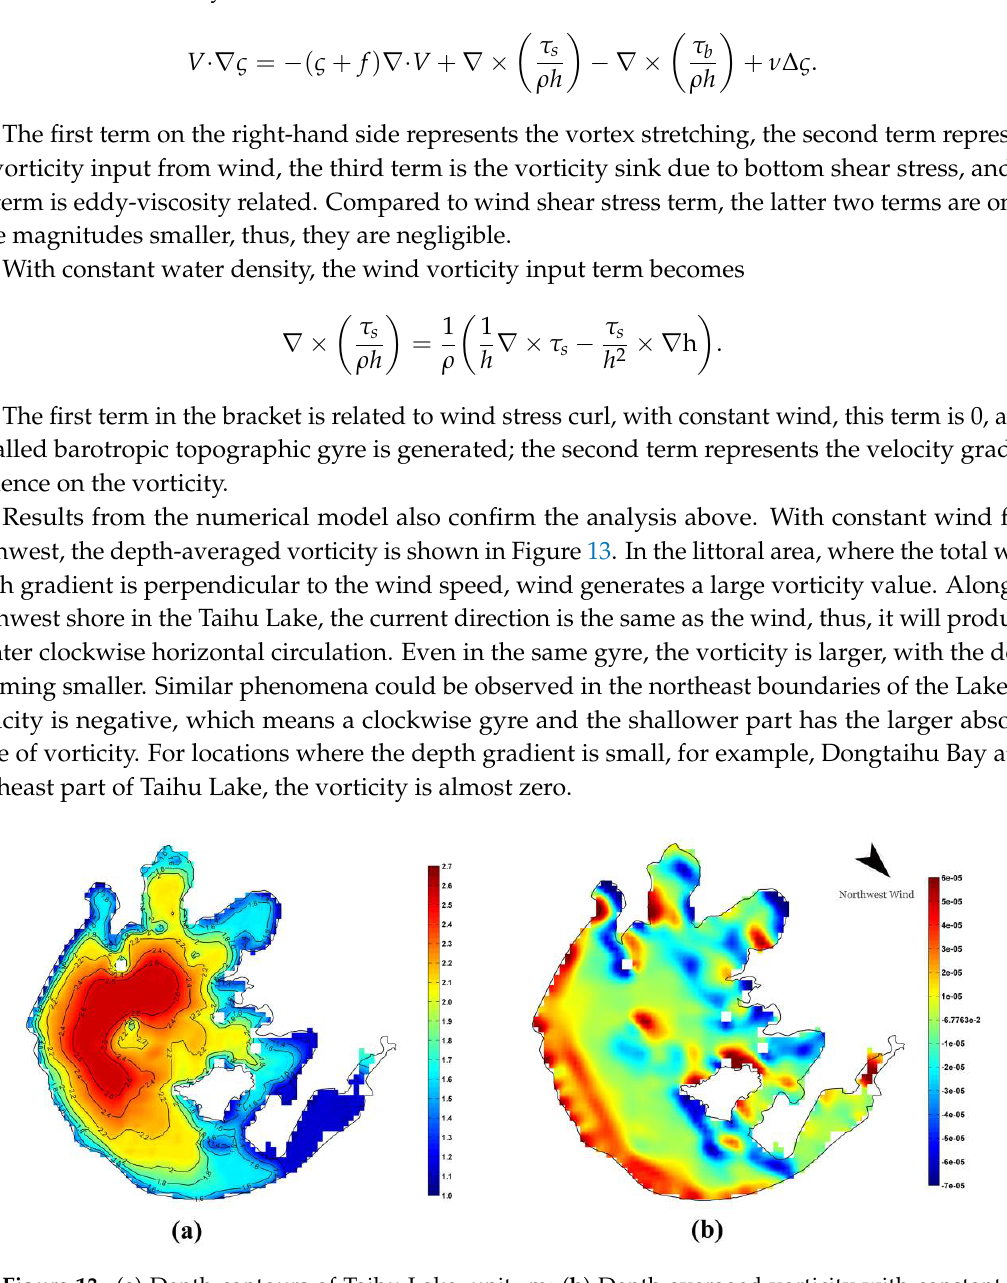
Figure 13. ( a ) Depth contours of Taihu Lake, unit: m; ( b ) Depth-averaged vorticity with constant northwest